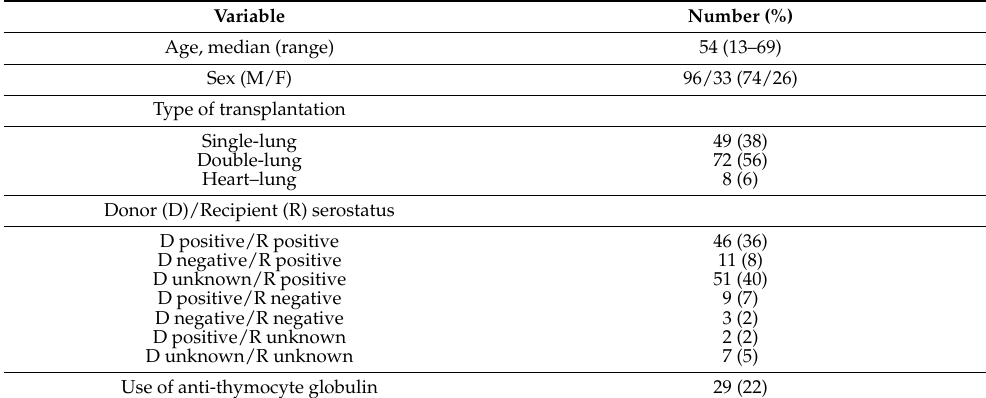
Table 1. Characteristics of the 129 patients analysed.